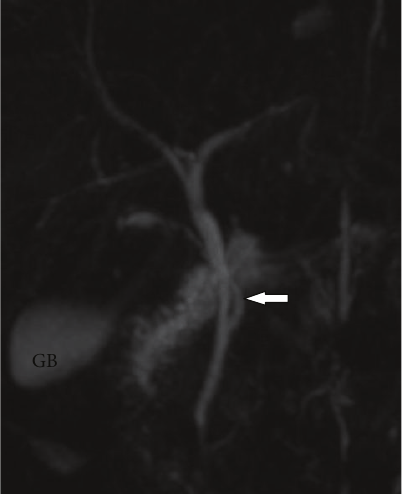
Figure2:Coronaloblique3DMRcholangiopancreatographyshows spiral course of cystic duct (white arrow) with medial insertion with CHD. GB: gall bladder.